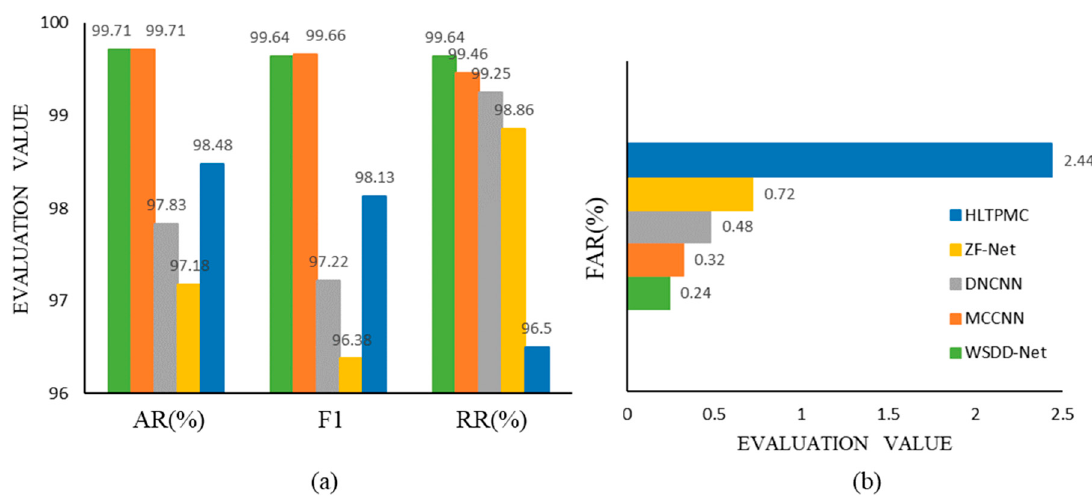
Figure 8. Experiment results using the Yuan dataset.